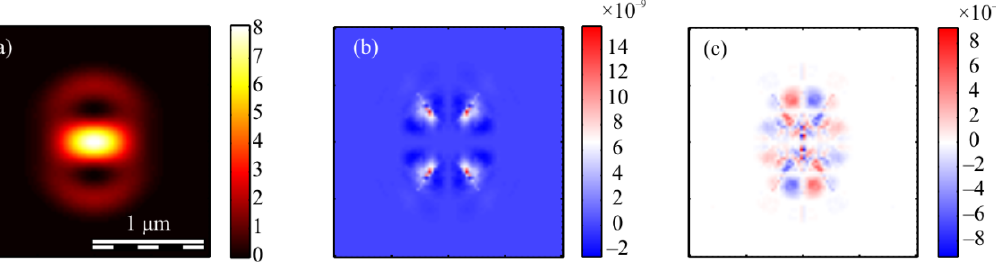
Figure 13. The Poynting vector components in the focus for m = 2 and a = 1: P z ( a ), P x ( b ), P y ( c ).